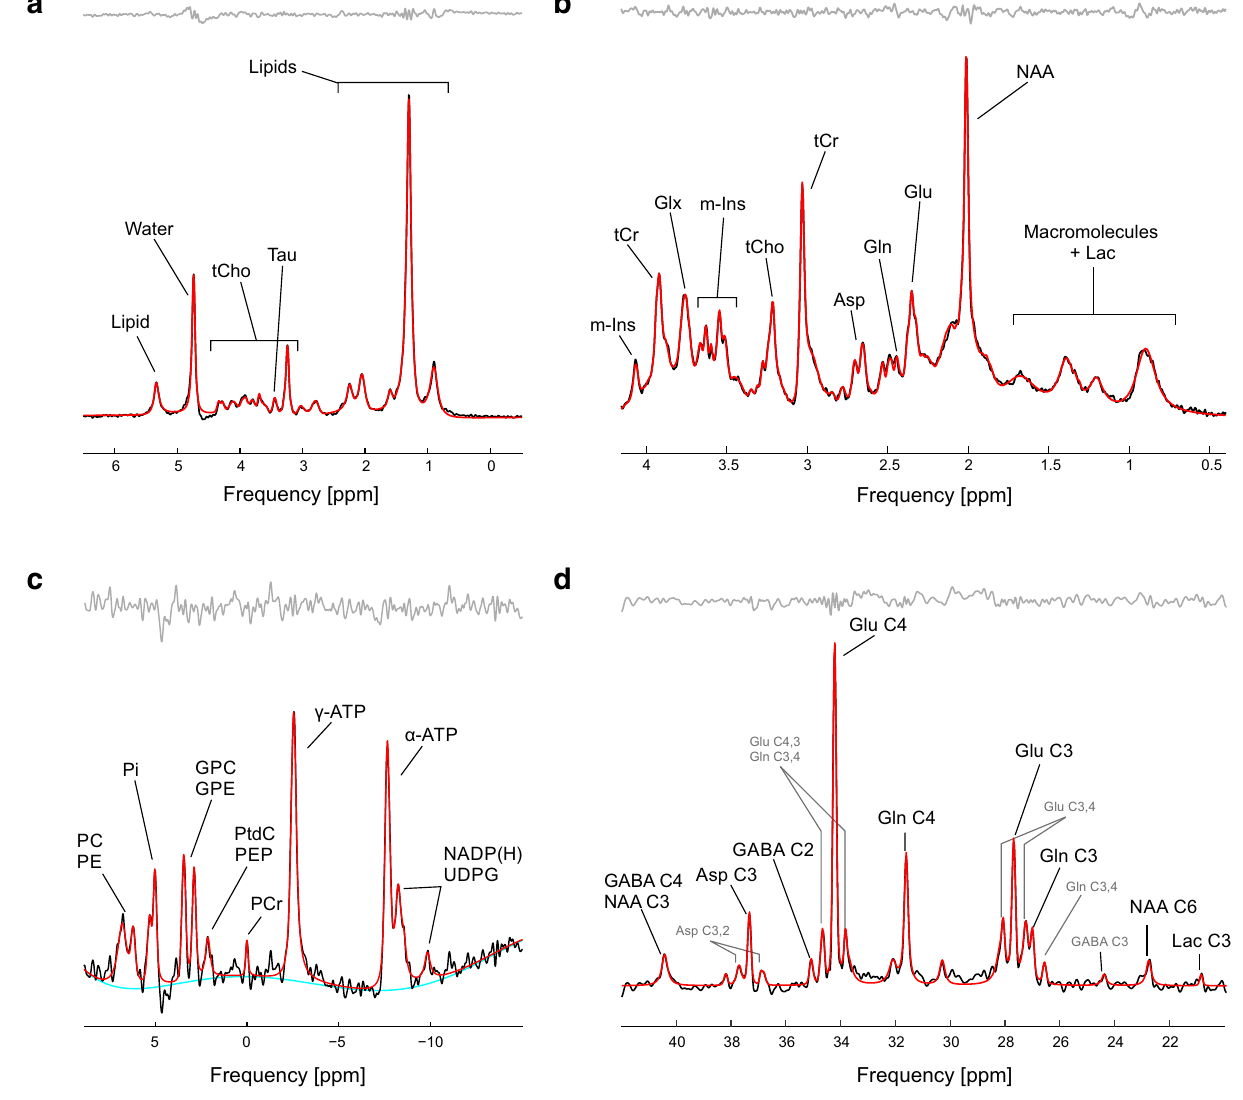
Figure 8. LCM analysis (red) of preclinical and X-nuclei spectra acquired in vivo (black). ( a ) Spectrum from pancreatic tumor in mouse measured at 9.4 T. The basis set consisted of lipid signals, water, total choline- containing compounds (tCho) and taurine (Tau) (Courtesy of Drs. Ken Olive and Yanping Sun, Columbia University, unpublished data). ( b ) Fit of a macaque monkey brain measured at 7 T 36 . Note that the resolution allowed visible separation of Gln and Glu signals at 2.35 and 2.45 ppm. ( c ) 31 P spectrum measured in the